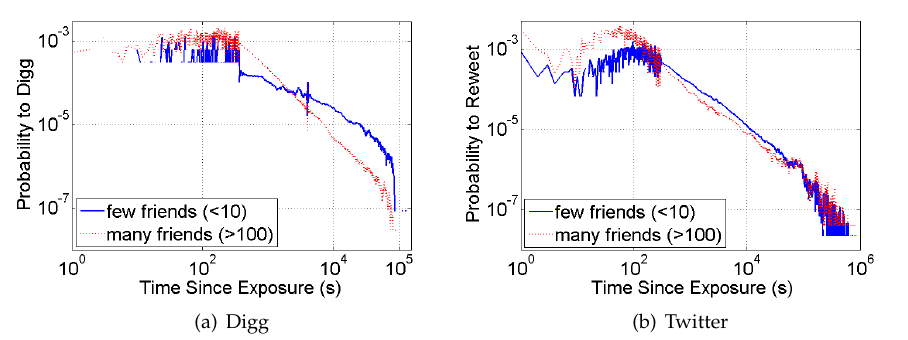
Figure 6. Time response function for social media. The probability to ( a ) digg a news story and ( b ) retweet a URL, as a function of the time since exposure, i.e. , message’s arrival in the user’s feed. To remove the confounding effects of multiple exposures, the figure only considers single exposure items. Digg stories were only followed until promotion (the first 24 hours) during which time they were only visible to the followers. The data are smoothed using progressively wider smoothing windows, as in